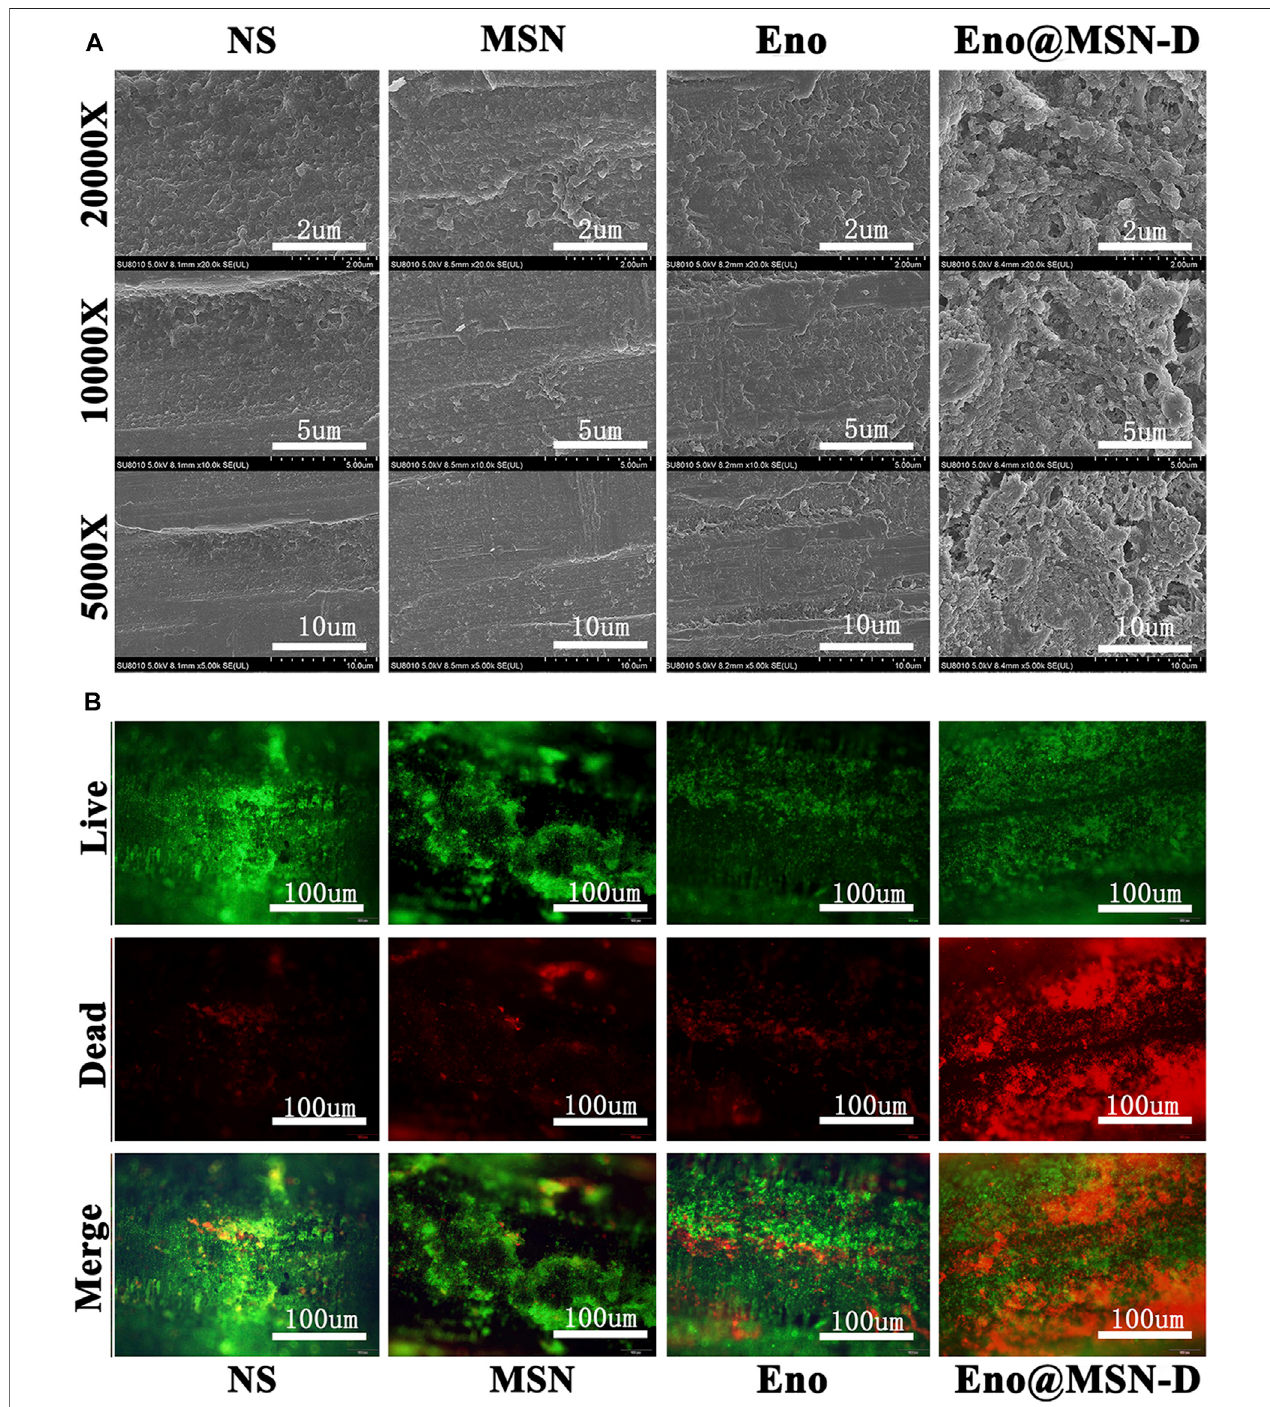
FIGURE 8 | (A) SEM images of bio fi lm on the surface of the titanium rod. (B) The live dead bacterial staining of the bio fi lm on the surface of the titanium rod was observed under an inverted microscope.